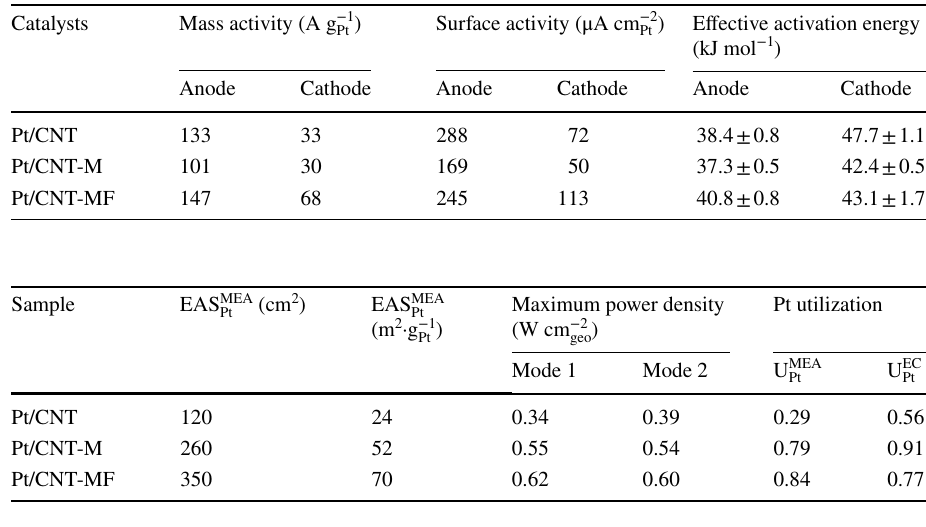
Table 3 Mass and surface activities and effective activation energies obtained at 0.9 V using anode and cathode scans